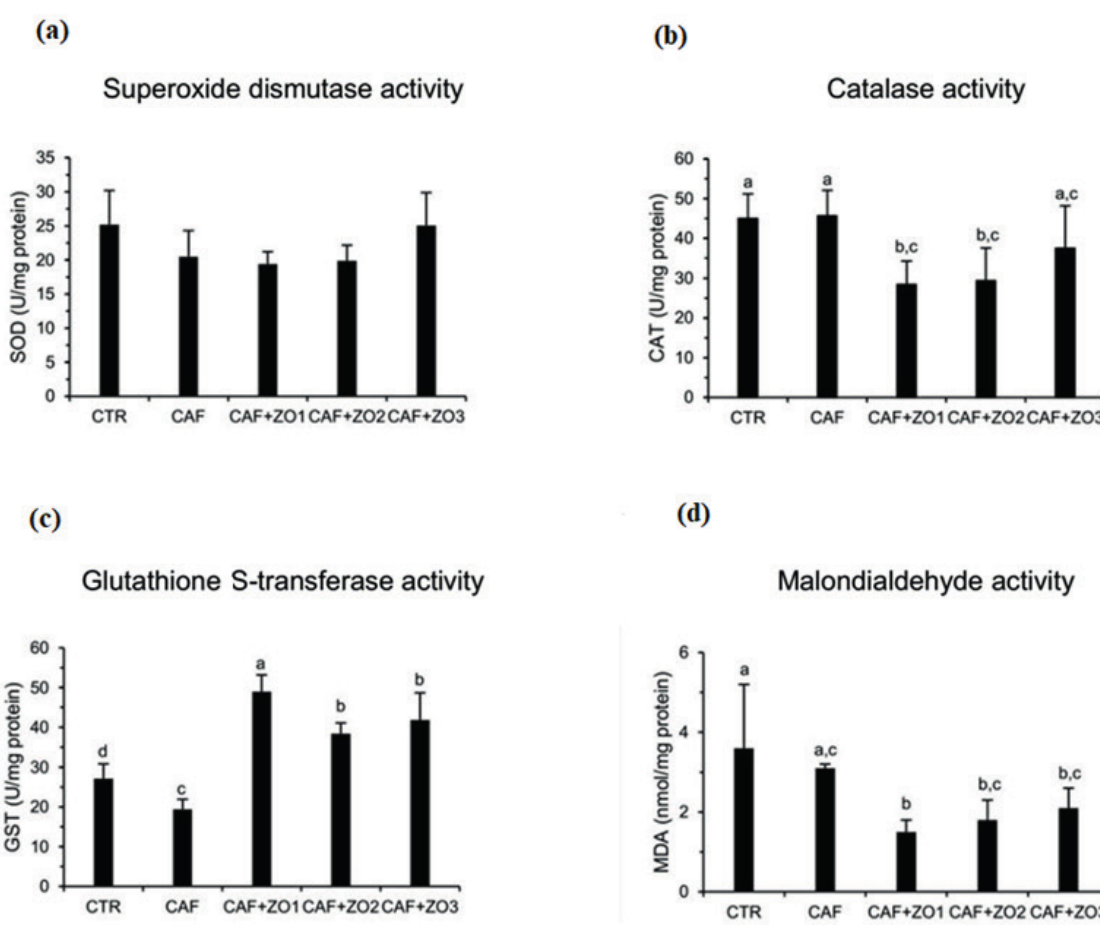
Figure 3 - Oxidative stress variables in the different experimental groups. Values expressed as mean ± standard deviation. CTR : control fed a comercial chow; CAF : cafeteria diet; ZO : formulation containing ginger; CAF + ZO1 : 75 mg/kg ZO ; CAF + ZO2 : 150 mg/kg ZO ; CAF + ZO3 : 300 mg/kg ZO ; ( a ) SOD: superoxide dismutase; ( b ) CAt: catalase; ( c ) GSt: glutathione-S- transferase; ( d ) MDA: malondialdehyde. a,b,c,d Different letters above the columns indicate a statistical difference (p <0.05) between the groups, by